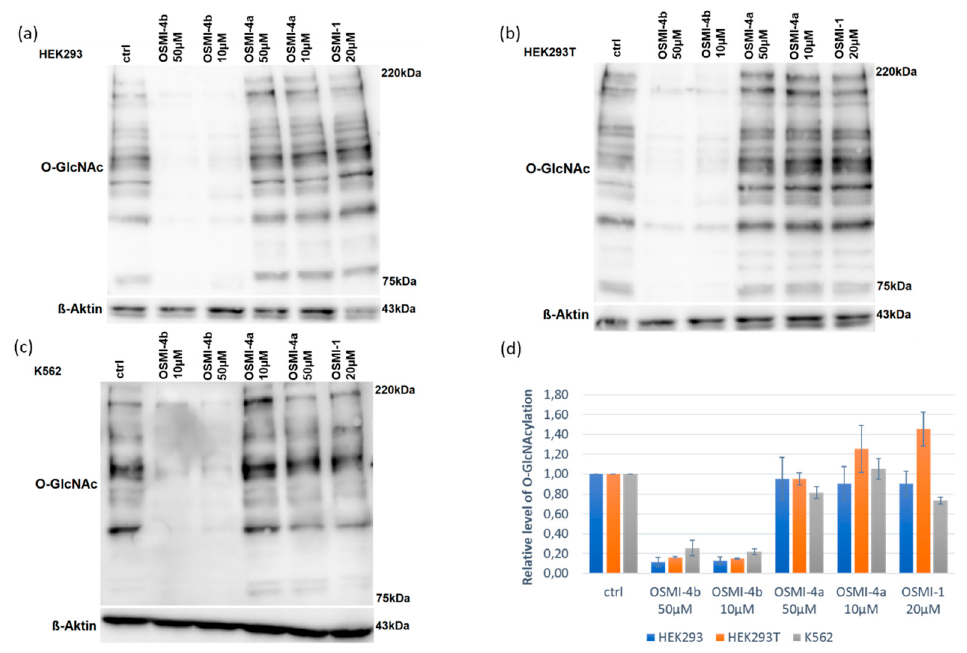
Figure 4. Effects of O -GlcNAcylation levels after 24h treating HEK293 ( a ), HEK293T ( b ), and K562 ( c ) cells with OSMI-1, OSMI-4a, and OSMI-4b. Western blotting for O -GlcNAc levels after treatment of cells with inhibitors at 10 µM (OSMI-4a, OSMI-4b), 20 µM (OSMI-1), or 50 µM (OSMI-4a, OSMI-4b) show that compound OSMI-4b and OSMI-1 are more effective than OSMI-4a; “ctrl” denotes DMSO control. Dose-dependent decreases in global O -GlcNAc levels were observed upon treatment with OSMI-4b in cells HEK293T and K562. ( d ) The western blot results are presented as the relative level of O -GlcNAcylation of the control cells stimulated with the vehicle from two to three independent experiments.